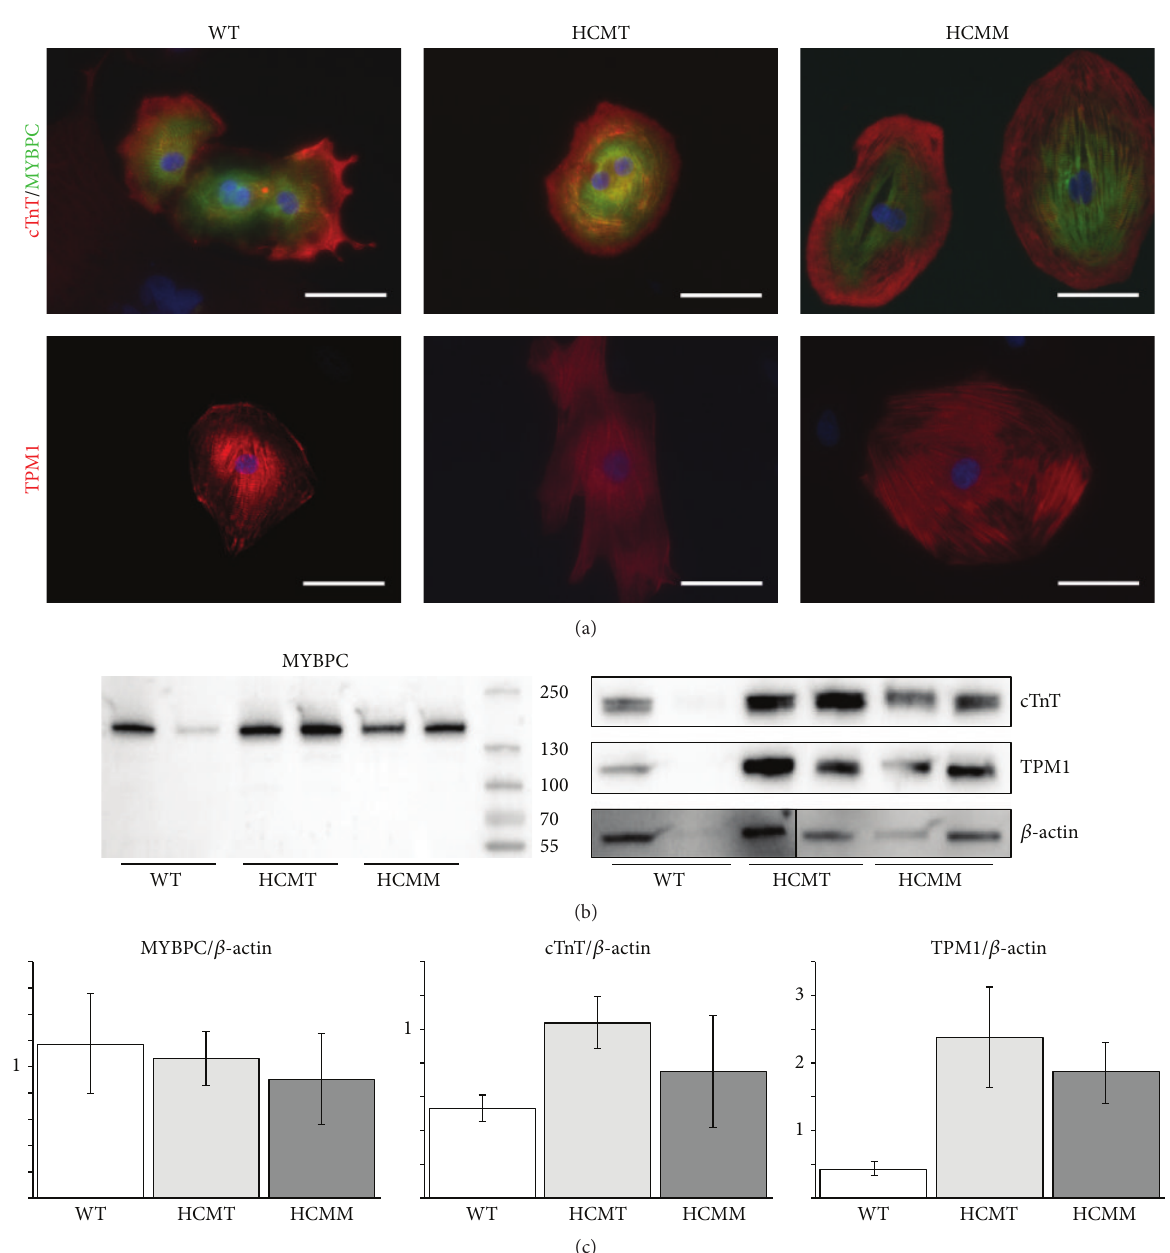
Figure 5: Cardiac-specific protein expression in hiPSC-derived CMs. (a) Representative images of hiPSC-derived CMs carrying TPM1- Asp175Asn mutation (HCMT) or MYBPC3-Gln1061X mutation (HCMM) and hiPSC-derived control CMs (WT) stained with cTnT, MYBPC, and TPM1. These images are not to quantify the protein expression but to demonstrate the presence of cTnT, MYBPC, and TPM1 proteins in the hiPSC-derived CMs. (b) hiPSC-derived CMs from all cell lines expressed MYBPC, cTnT, and TPM1 proteins. The truncated MYBPC was not detected in HCMM cells (size of the wild type protein 141 kDa and the predicted size of the truncated protein 117kDa). (c) The expression of MYBPC, cTnT, and TPM1 in WT-CMs, HCMT-CMs, and HCMM-CMs normalized to the expression of 𝛽 -actin. Protein expressions were quantified from western blots using ImageJ software. Quantitation data show the averages of MYBPC/ 𝛽 -actin, cTnT/ 𝛽 -actin, and TPM1/ 𝛽 - actin relations from hiPSC-derived CMs from two different hiPSC lines in each group. Because of the lack of replicates, statistical analysis was not